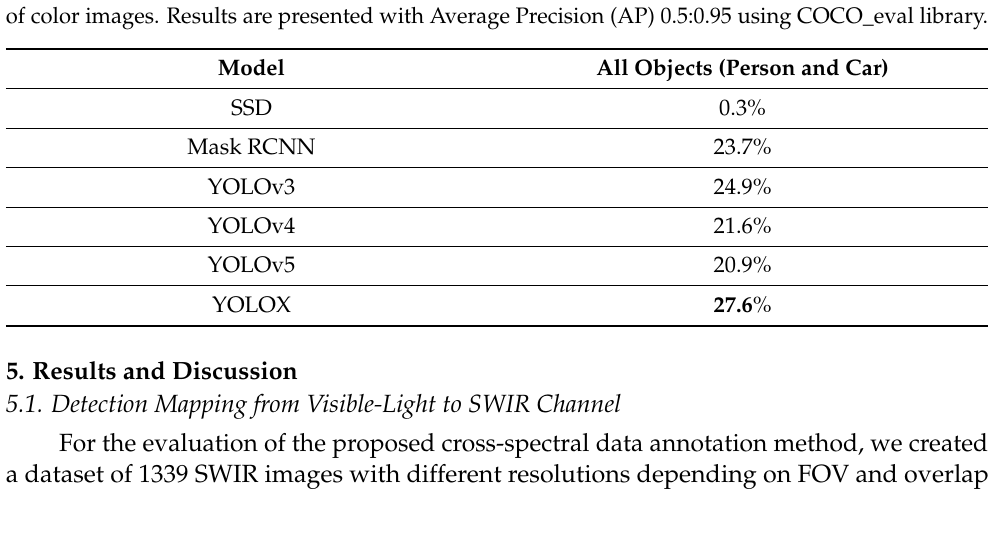
Table 3. Comparative results of different models for the person and car classes detection on a dataset of color images. Results are presented with Average Precision (AP) 0.5:0.95 using COCO_eval li- brary.